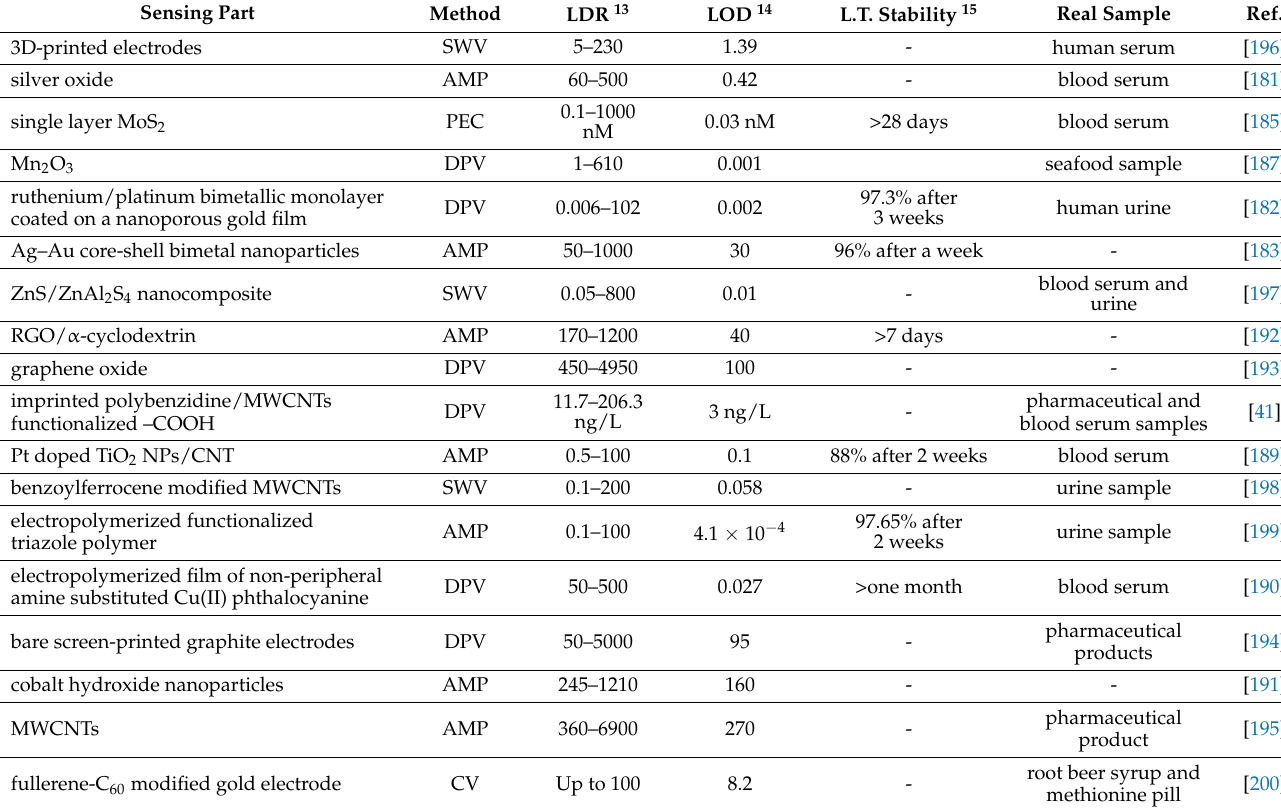
Table 3. Proposed electrochemical methionine sensors, since 2010, along with the most important respective figures of merit. Sensing